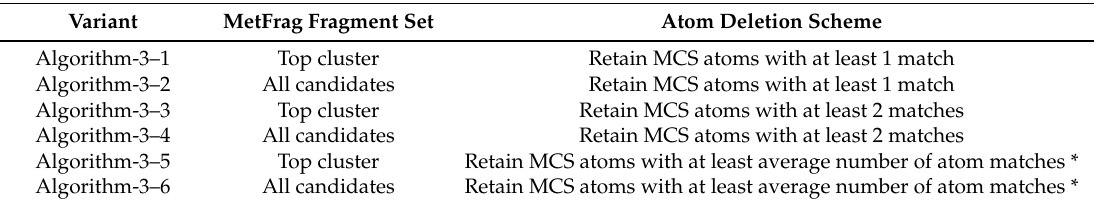
Table 5. Variants of Algorithm-3.